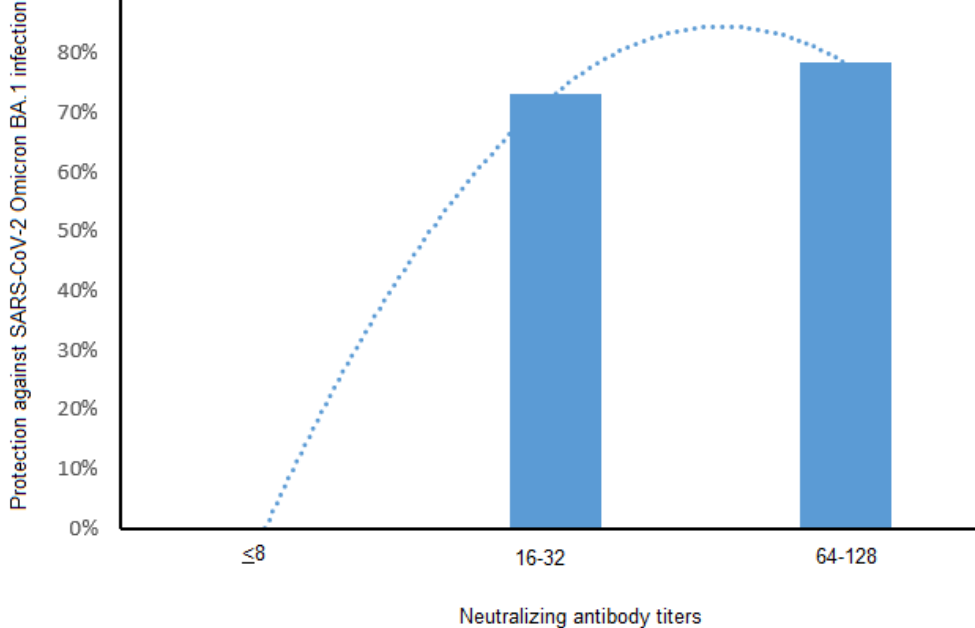
Figure 4. BA.1 neutralizing antibody titers and protection against SARS-CoV-2 Omicron BA.1 infection/re-infection with polynomial trend curve (dotted line).